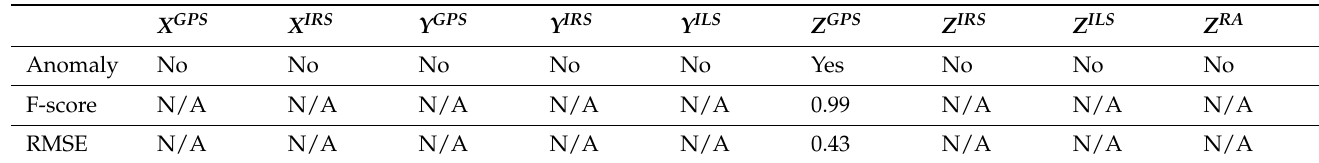
Table 3. Result for each signal after using